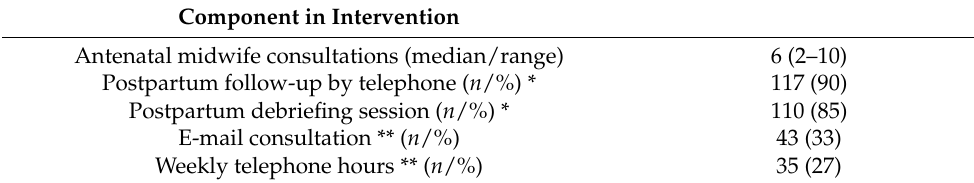
Table 2. Adherence to the ChroPreg intervention ( n = 130).